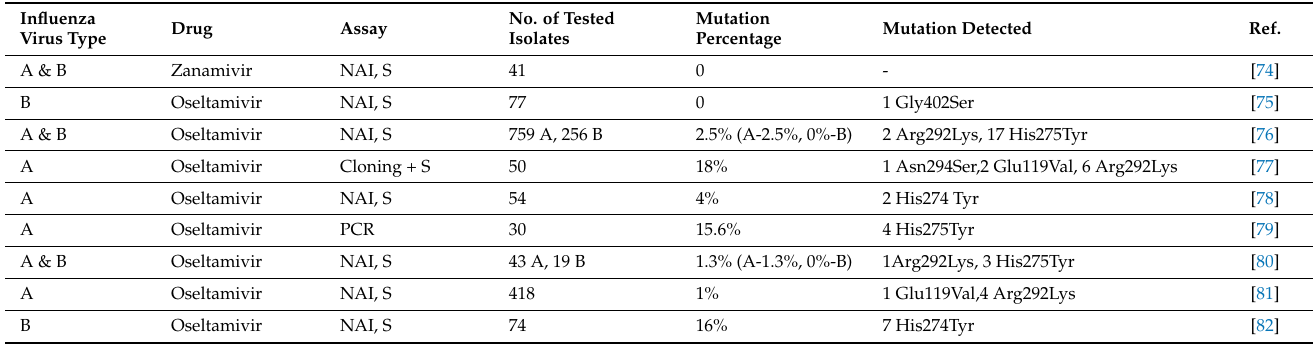
Table 2. Reports of drug mutations and their frequencies in different influenza virus